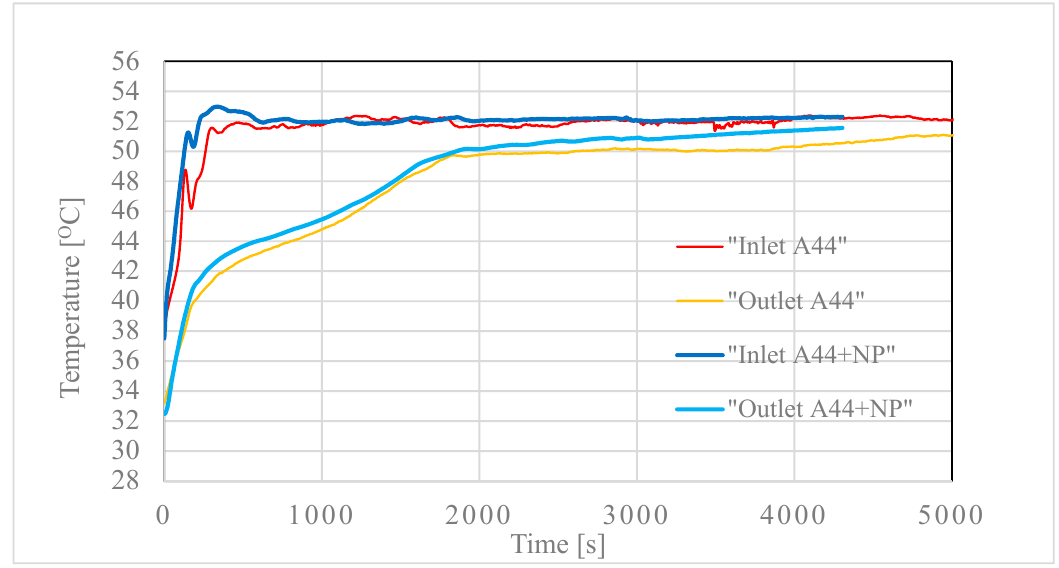
Figure 10. Comparison of HTF temperature evolution in case of pure A44 and A44 with nano-particles (A44 + NP) upon charging.